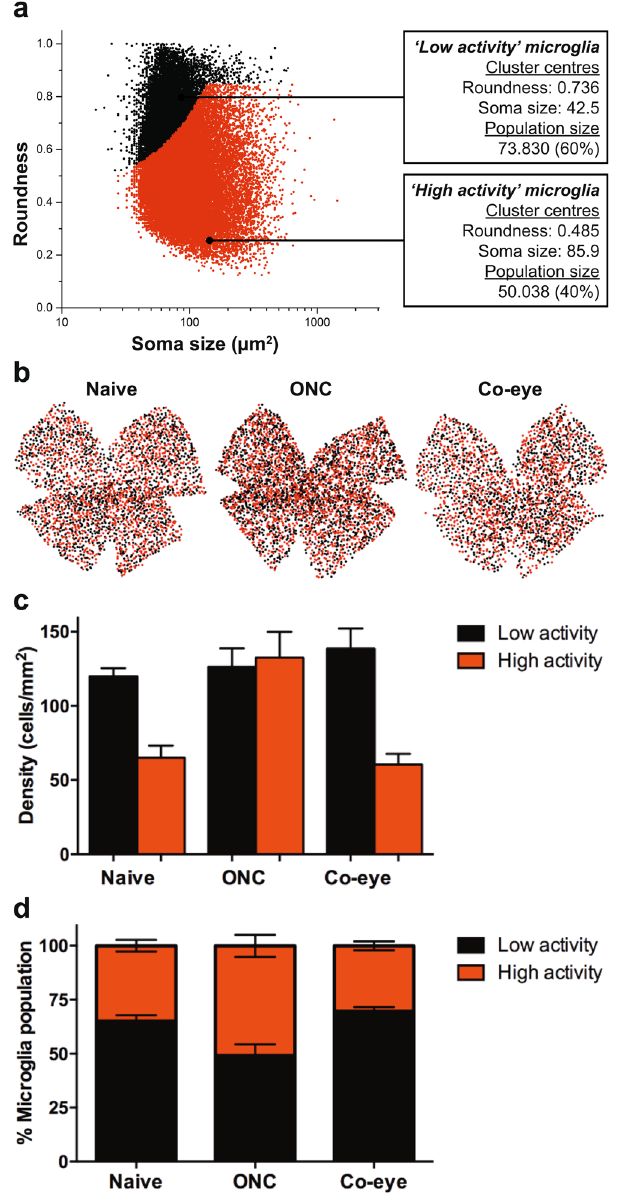
Figure 4. K -means clustering into ‘low activity’ and ‘high activity’ microglia subpopulations. ( a ) Two subpopulations of microglia were defined via K -means cluster analysis of a total of 123.868 cells ( i.e ., the sum of microglia from 14 naive retinas, 14 ONC retinas and 14 contralateral retinas), based on their roundness and soma size. ( b ) Images of representative retinal whole-mounts from naive, ONC and contralateral eyes, showing the distribution of ‘high activity’ (red) and ‘low activity’ (black) microglia. Each dot represents a microglia cell. ( c ) Absolute numbers of ‘low activity’ and ‘high activity’ microglia in the retina reveal that microgliosis after ONC merely presents as an increase in the number of ‘high activity’ microglia (one-way ANOVA with Tukey’s post hoc test). ( d ) This results in an increased proportion of ‘high activity’ versus ‘low activity’ microglia at day 4 post ONC, in comparison to naive retinas. No significant changes were observed in the contralateral eye. Data are depicted as mean ± 95% confidence